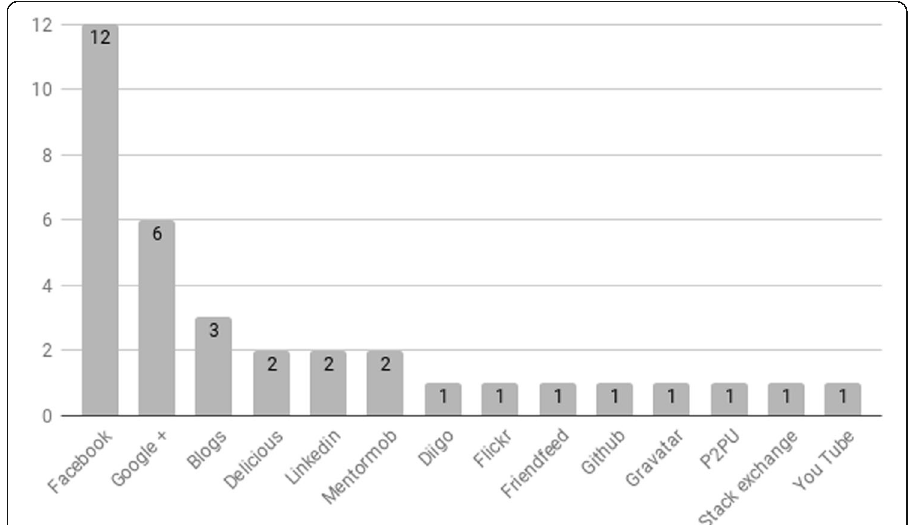
Fig. 3 Other Social Networks Considered Beyond